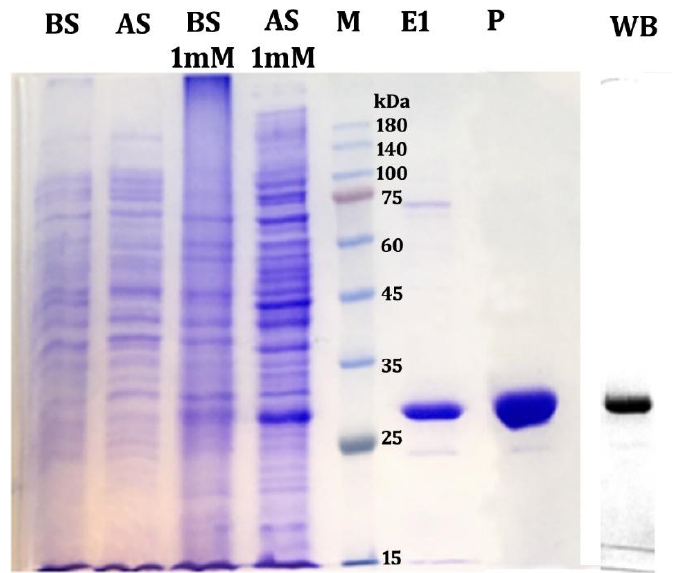
Figure 1. Profile of protein expression in E. coli BL21 (DE3) pLysS cells with and without IPTG. Lane